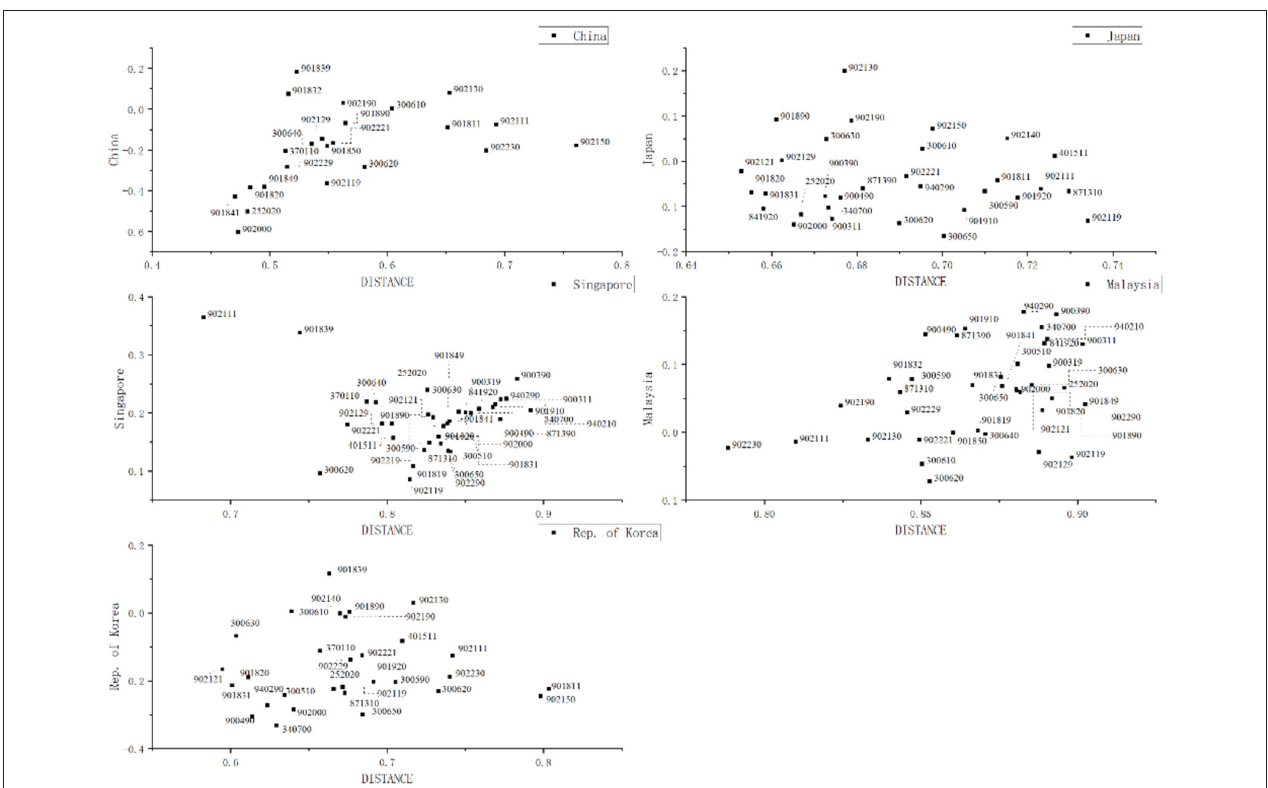
FIGURE 9 | Distance-opportunity gain graphs for potential medical device